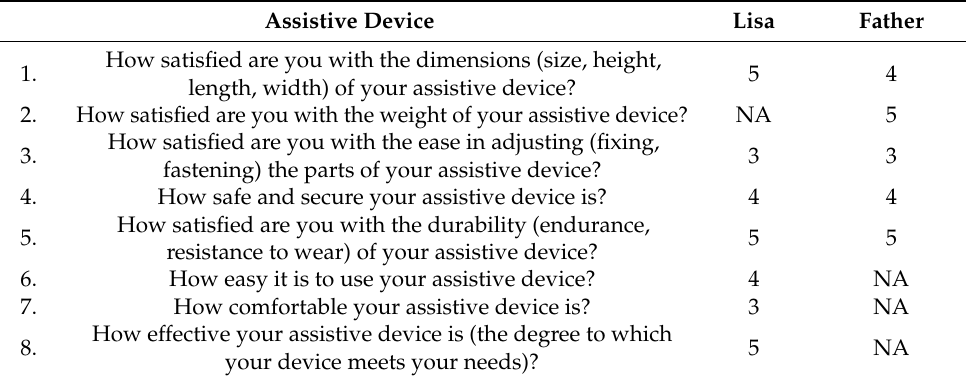
Table 1. Quebec User Evaluation of Satisfaction with Assistive